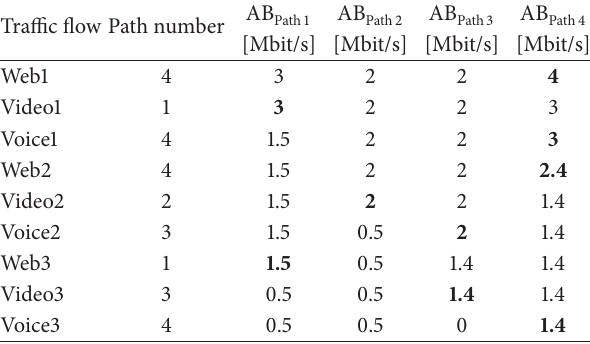
Table 3: The path selection and the available bandwidth of the paths using SWP.